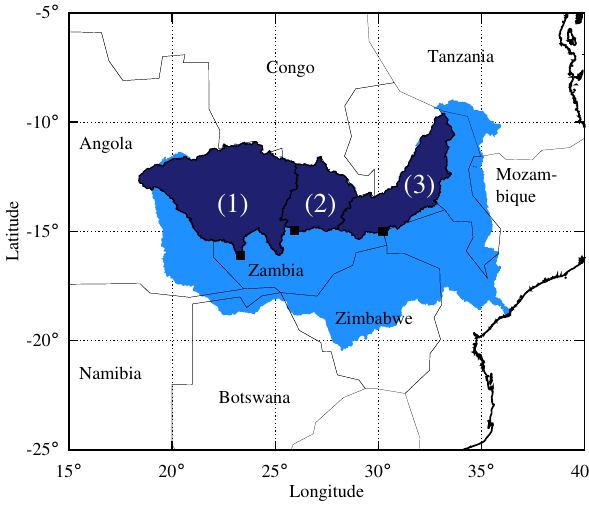
Fig. 1. Overview of the Zambezi River Basin (light blue) and the three watersheds where the model is applied. (1) Upper Zam- bezi; (2) Kafue River; (3) Luangwa River. The outlets of the water- sheds are marked ( (cid:4)